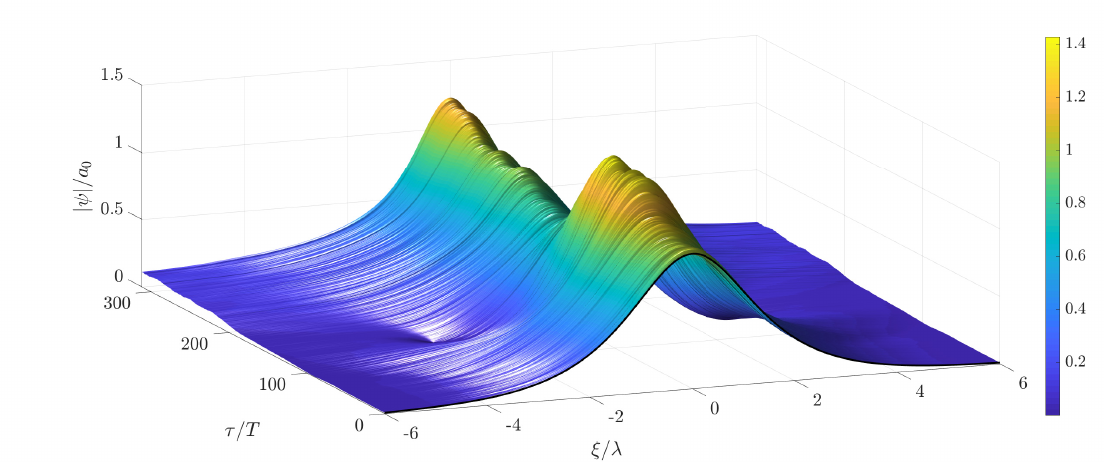
Figure 3. Temporal evolution of a solution of the stochastic NLS with white noise excitation in time and a soliton solution as initial condition. Strong random forcing χ ( τ ) with a variance σ 2 = 0.21/s 2